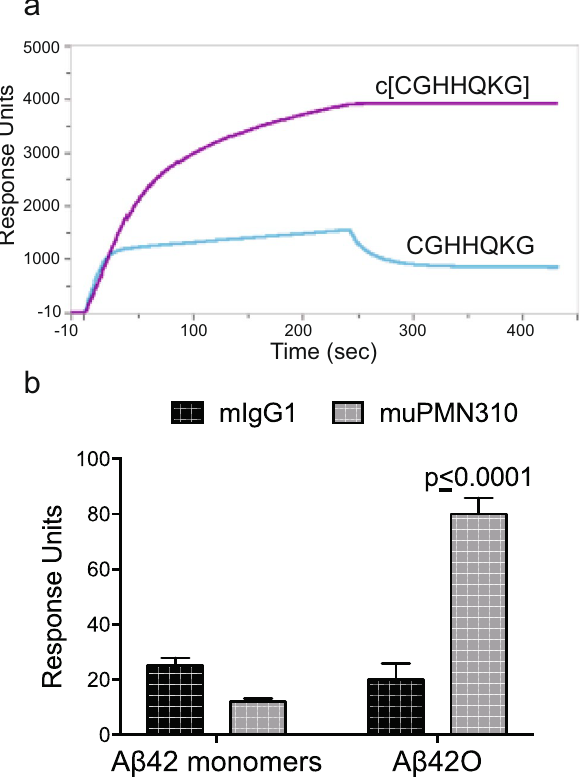
Figure 2. Selective binding of the muPMN310 antibody to cyclized CGHHQKG peptide and A β oligomers. ( a ) SPR measurements of muPMN310 binding to cognate cyclized peptide epitope c[CGHHQKG], and unstructured linear CGHHQKG peptide. Representative sensorgrams from two independent experiments are shown. ( b ) SPR measurements of muPMN310 binding to A β 42 monomers and oligomers (A β 42O). Means and SEM of three identical experiments are shown. Differences were determined by two-way ANOVA with Sidak’s multiple comparison test: muPMN310 binding to A β 42O is significantly higher than all other measurements (p ≤ 0.0001); muPMN310 binding to A β 42 monomers is not different from isotype control (mIgG1) by two-way